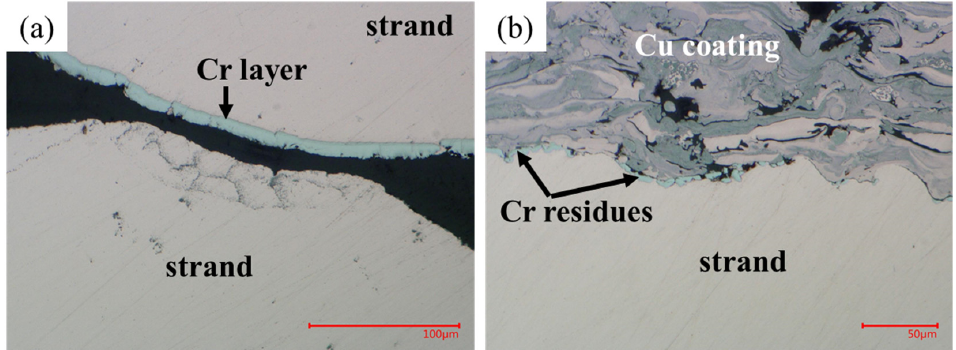
Figure 7. Comparison between the Cr layer of an internal strand ( a ) and the Cr residues on a strand on the surface of the cable after sandblasting and Cu spraying ( b ).